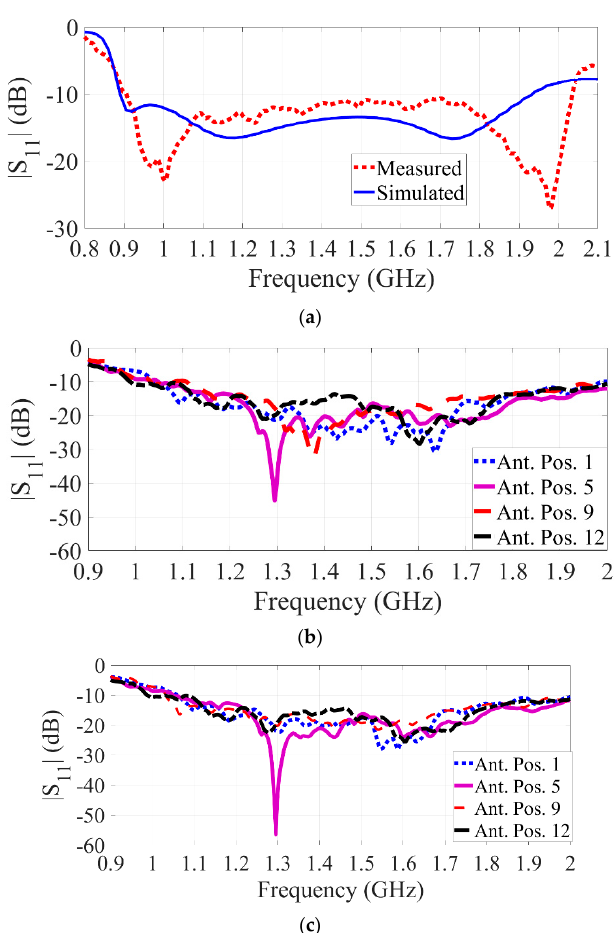
Figure 7. |S 11 | performance of the ( a ) isolated single antenna after VNA calibration; and |S 11 | performance of the antenna in the array in the integrated system for four arbitrary positions: ( b ) when the imaging domain is empty, and ( c ) when unhealthy case is present.